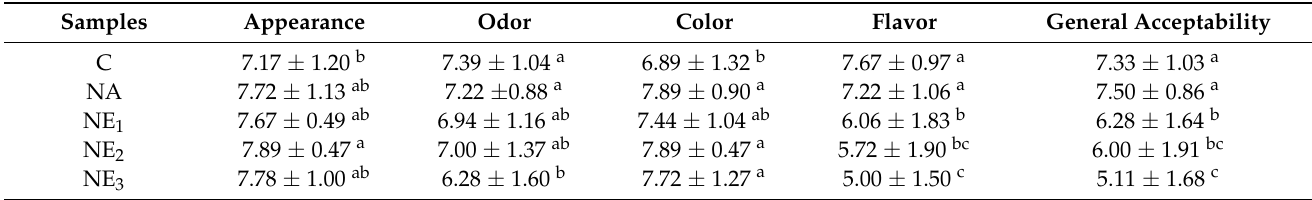
Table 5. The effect of nanoemulsion coating on the sensory properties of the cheese